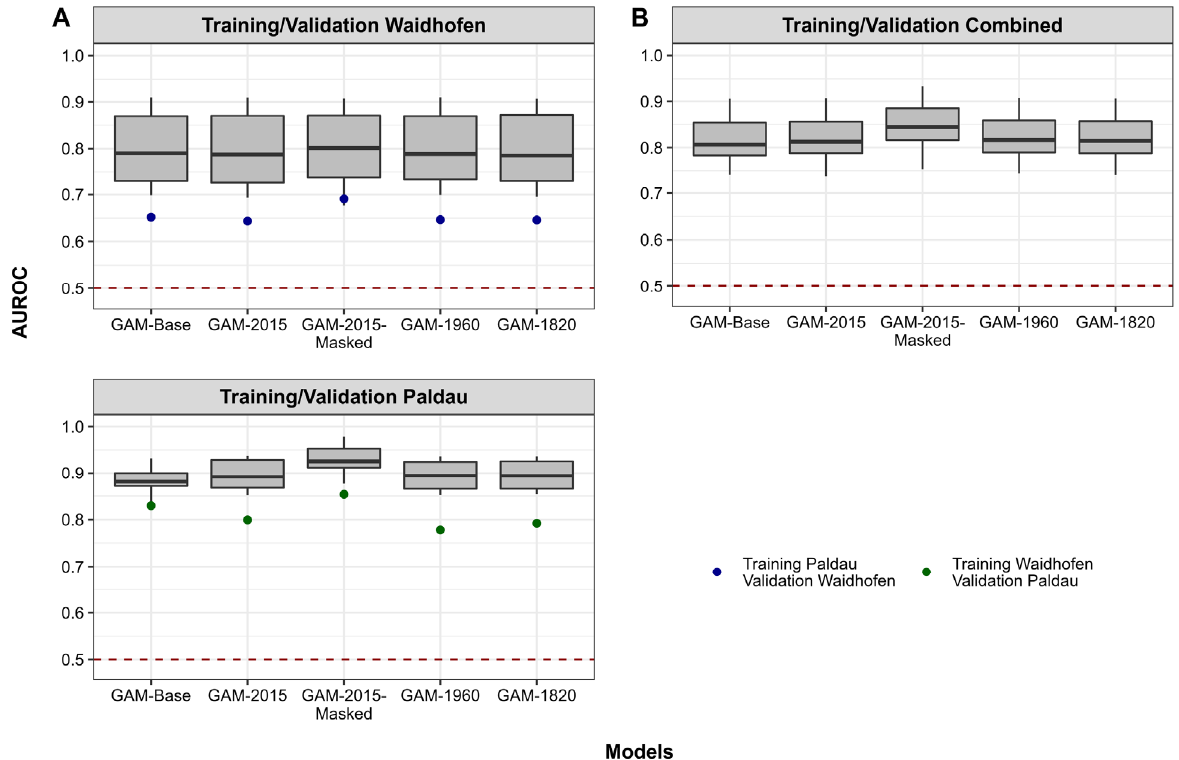
Figure 3. Model performance in SpCV and transferability assessment. ( A ): Study-area specific SpCV and transferability estimates. ( B ): SpCV estimates using the combined data from both municipalities.